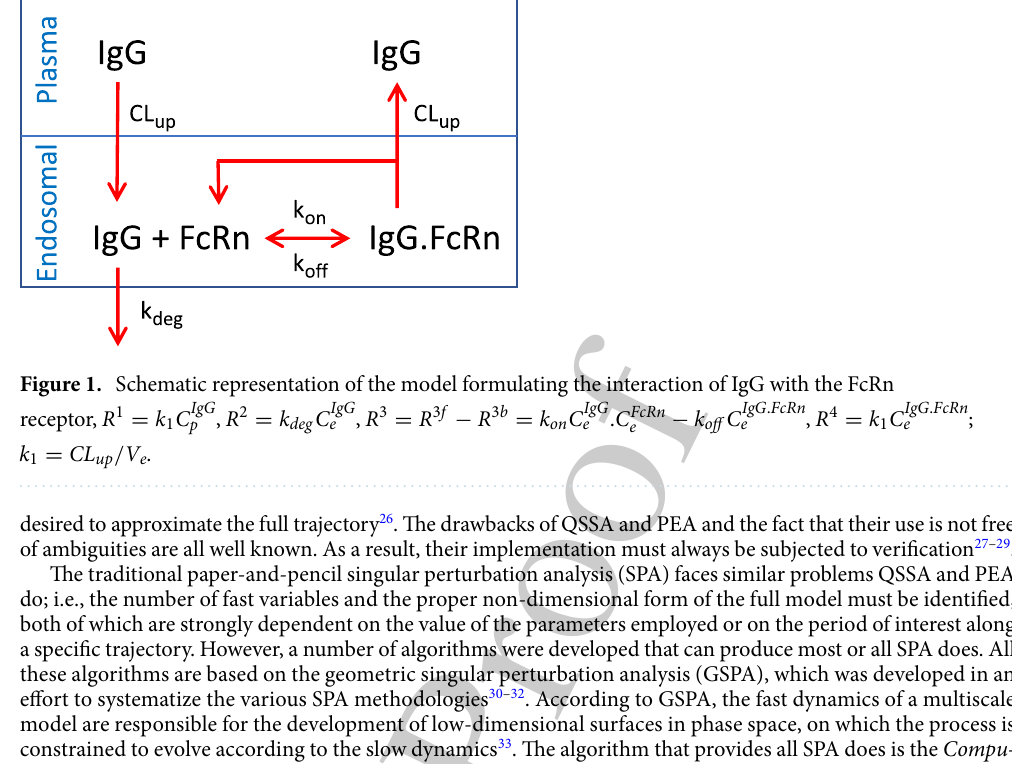
IgG IgG 2 = k 3 = R 3 f − R 3 b = k e , R deg C p , R